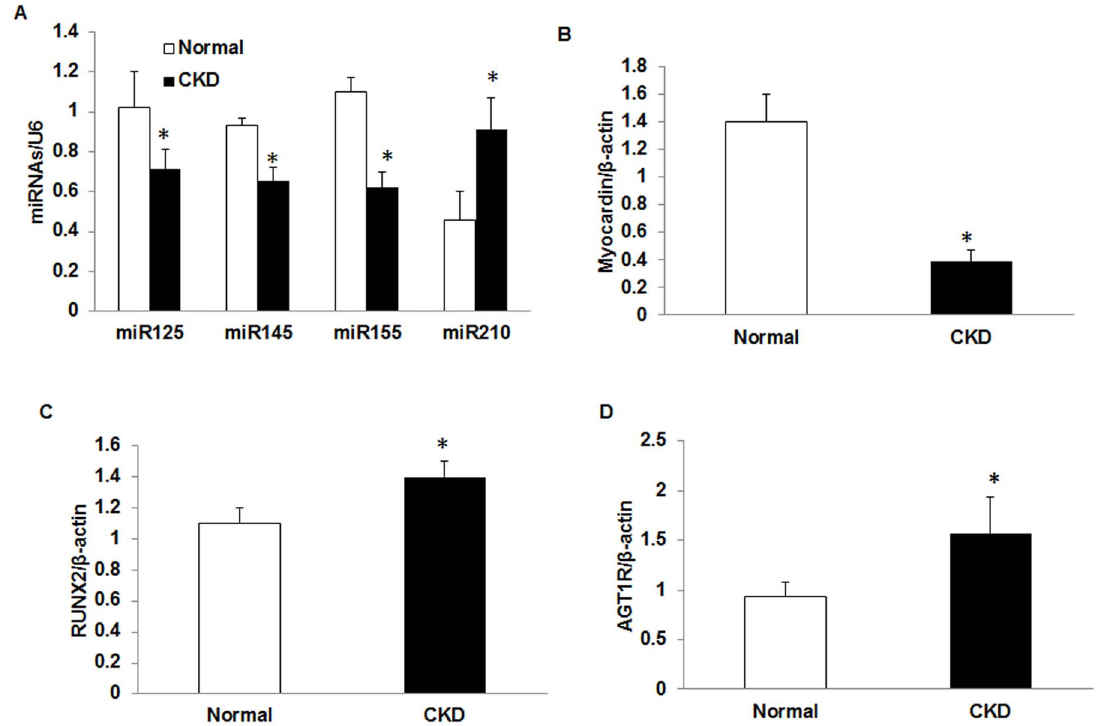
Figure 3. The Expression of vascular microRNAs and target genes in VSMCs from normal and CKD rats. Rat VSMC isolated from normal or CKD rats were cultured in growth media for 4 days and total RNA isolated. Real time PCR was performed to determine the expression of miR-125b, miR-145, miR-155 and miR-210 and normalized by U6 (A). The expression of myocardin (B), RUNX2 (C) and AT1R (D) was also determined by real time PCR and normalized by b -actin. Each sample (n=9 with cells isolated from 3 different normal or CKD animals) was assayed in triplicate. Data were expressed as mean 6 SEM. * p , 0.05, CKD vs. normal.